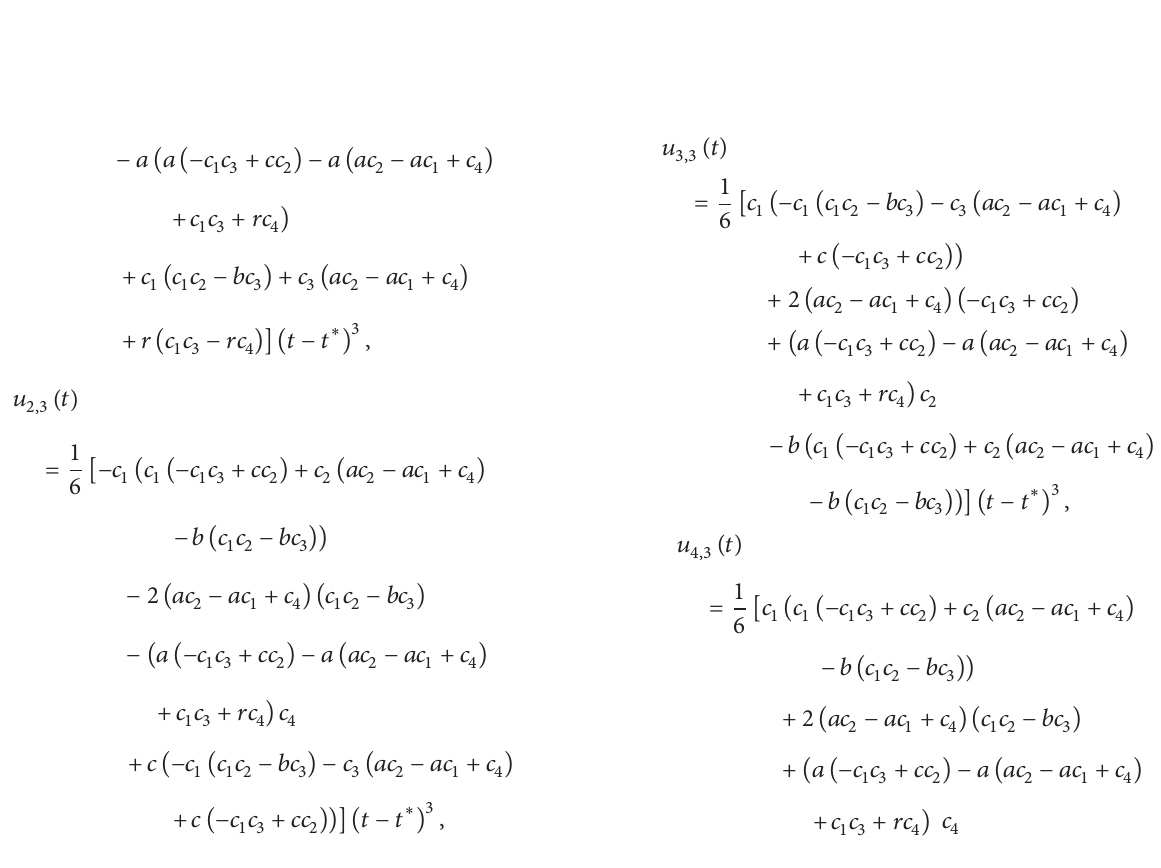
Figure 2: Phase portraits of 15-term MHPM of Chaotic L¨u